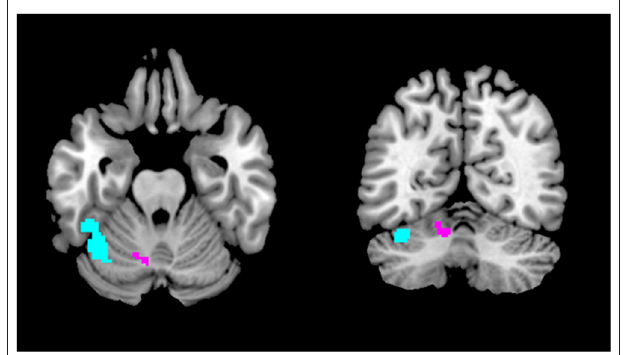
FIGURE 2 | Regions of the cerebellum implicated in VSS pathophysiology. The area in purple showed gray matter volume increase with VBM (16), whereas the region in light blue showed increased regional cerebral blood flow with ASL (17) and altered functional connectivity to the posterior cingulate cortex with resting state fMRI